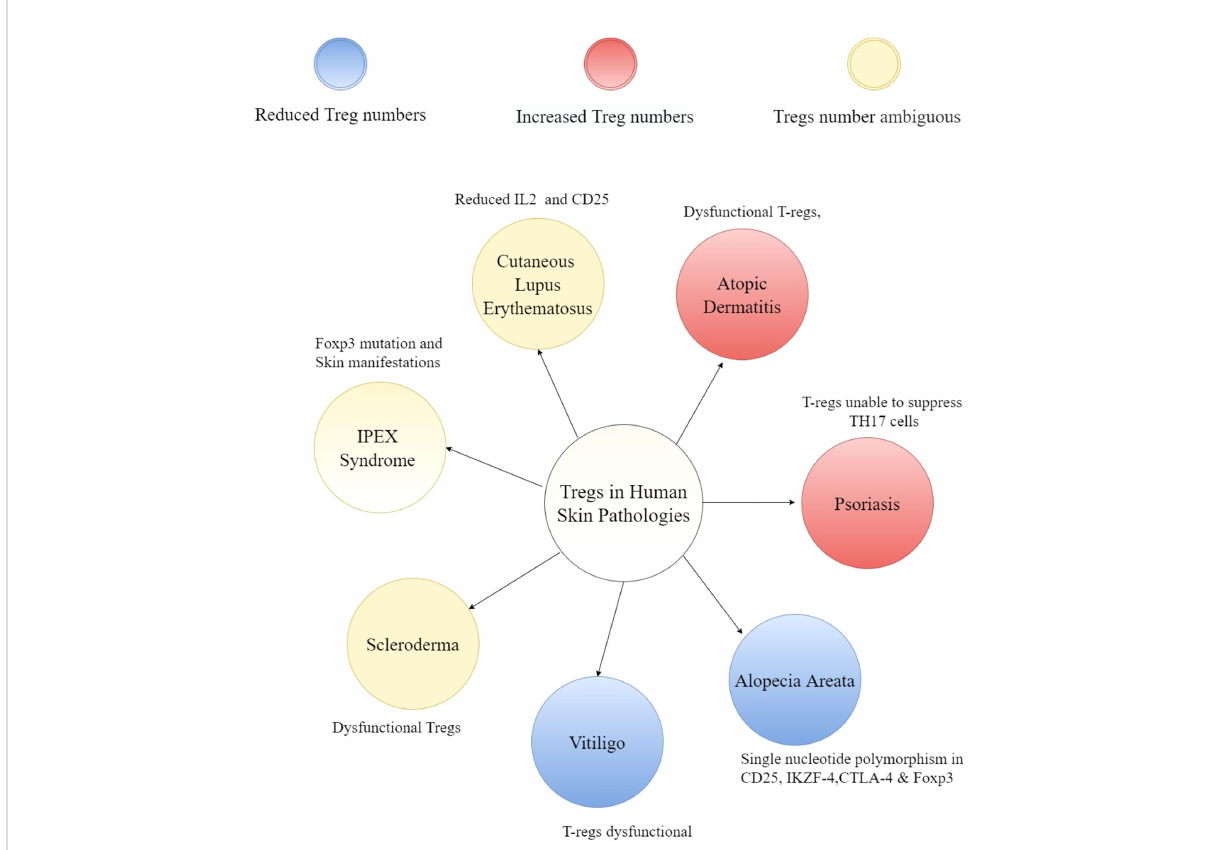
FIGURE 3 Overview of T-regs in human skin pathologies. A hub and spoke diagram summarizing the potential impact of T-regs and cytokines in fl uencing the niche disease